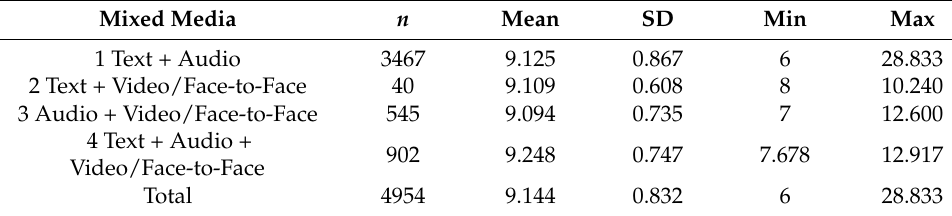
Table 8. Descriptive statistics—satisfaction in mixed